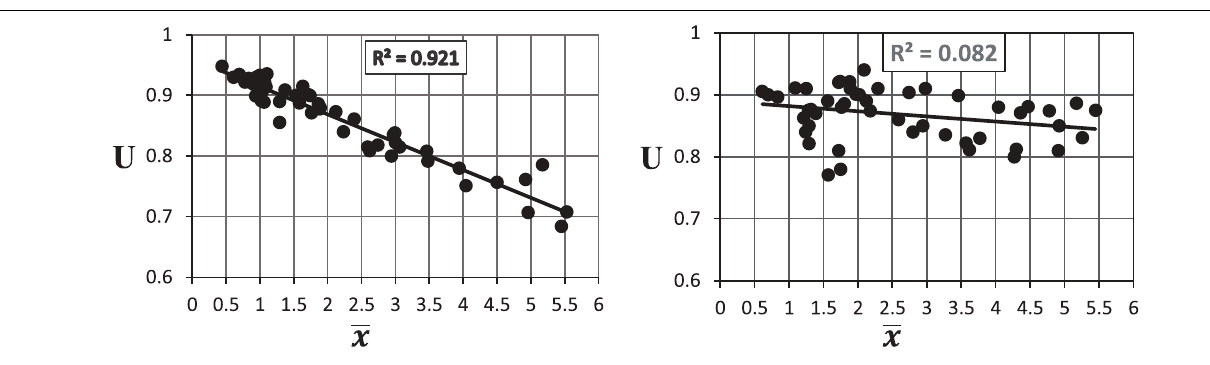
FIGURE 6 | U vs. d ¯ x based on FEA for W (left) and WT (right) sections (12 in. connection).